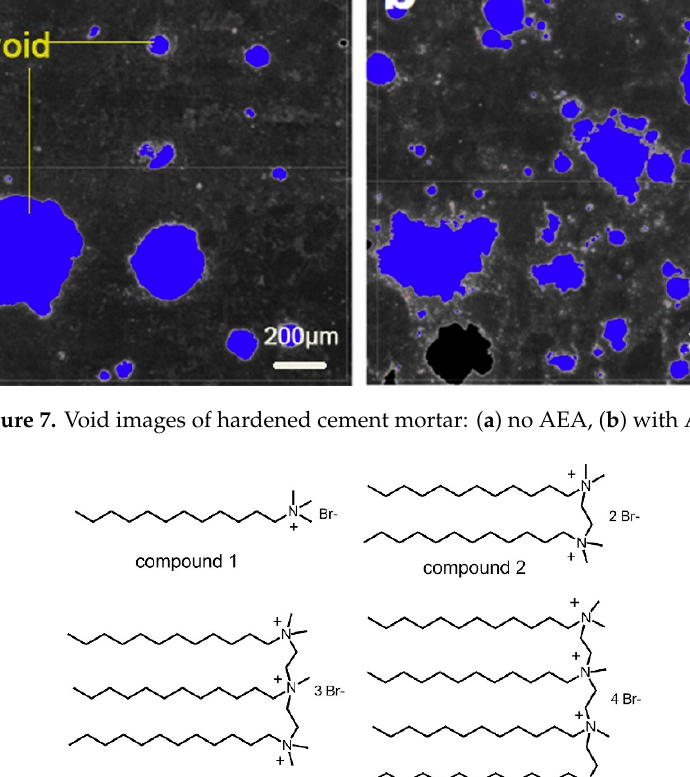
Figure 7. Void images of hardened cement mortar: ( a ) no AEA, ( b ) with AEA.